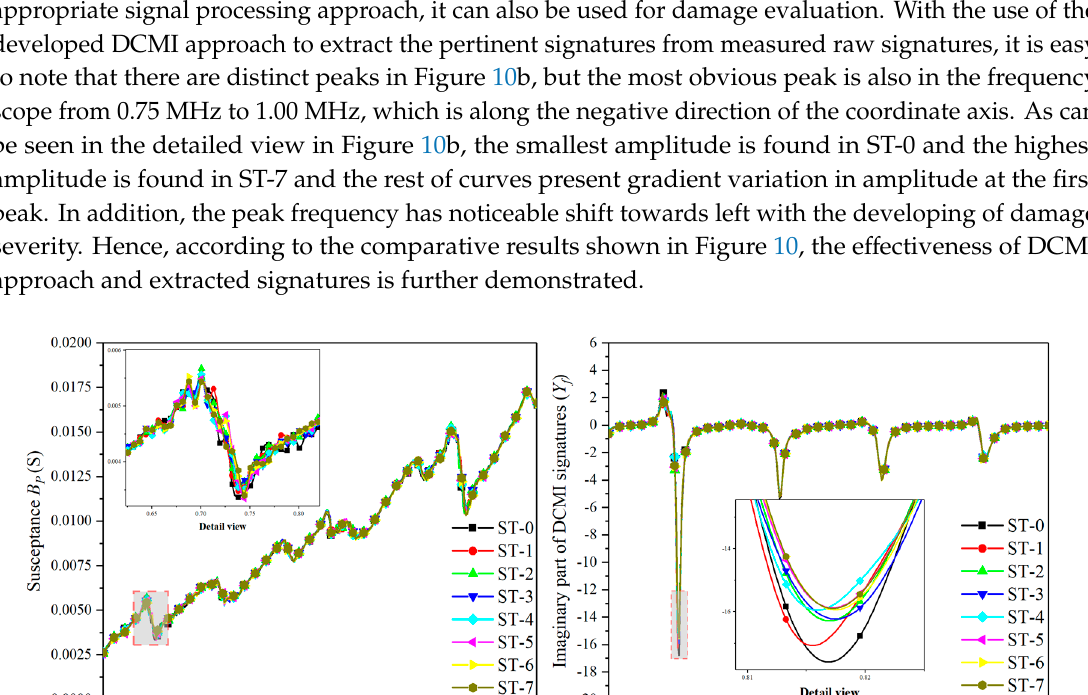
Figure 10. Comparative plots based on imaginary part of signatures for specimen-2: ( a ) raw susceptance signatures B P , ( b ) extracted DCMI signatures Y f .